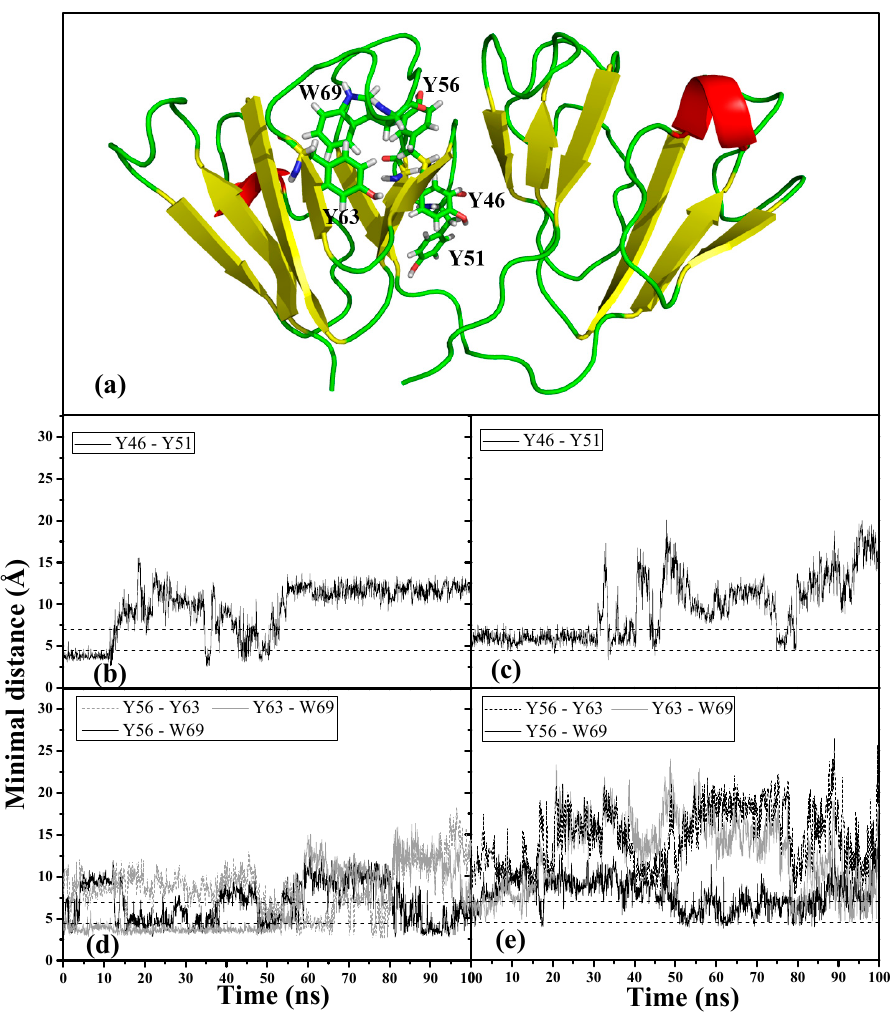
Figure 6. Important aromatic residues and associated interactions within motif 2. ( a ) Positions of the residues (represented by stick form) forming aromatic cluster (Y63–W69–Y56) and Tyr-pair (Y46–Y51). Minimal distance between the Tyr-pair in ( b ) urea-induced and ( c ) GdnHCl-induced structures as a function of simulation time. Minimal distance between aromatic cluster residues in ( d ) urea-induced and ( e ) GdnHCl-induced structures as a function of simulation time. Dash lines denote aromatic–aromatic residue interaction range found in most proteins [34]. Table 1. Percentage of the important aromatic–aromatic interactions present within motif 2 of the denaturant-induced higher-energy-state structures throughout 100 ns simulation time, 425 K. Aromatic